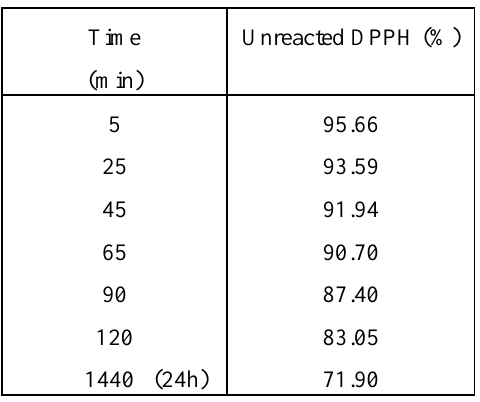
(molar ratio = 1 : 5 : 5). 2